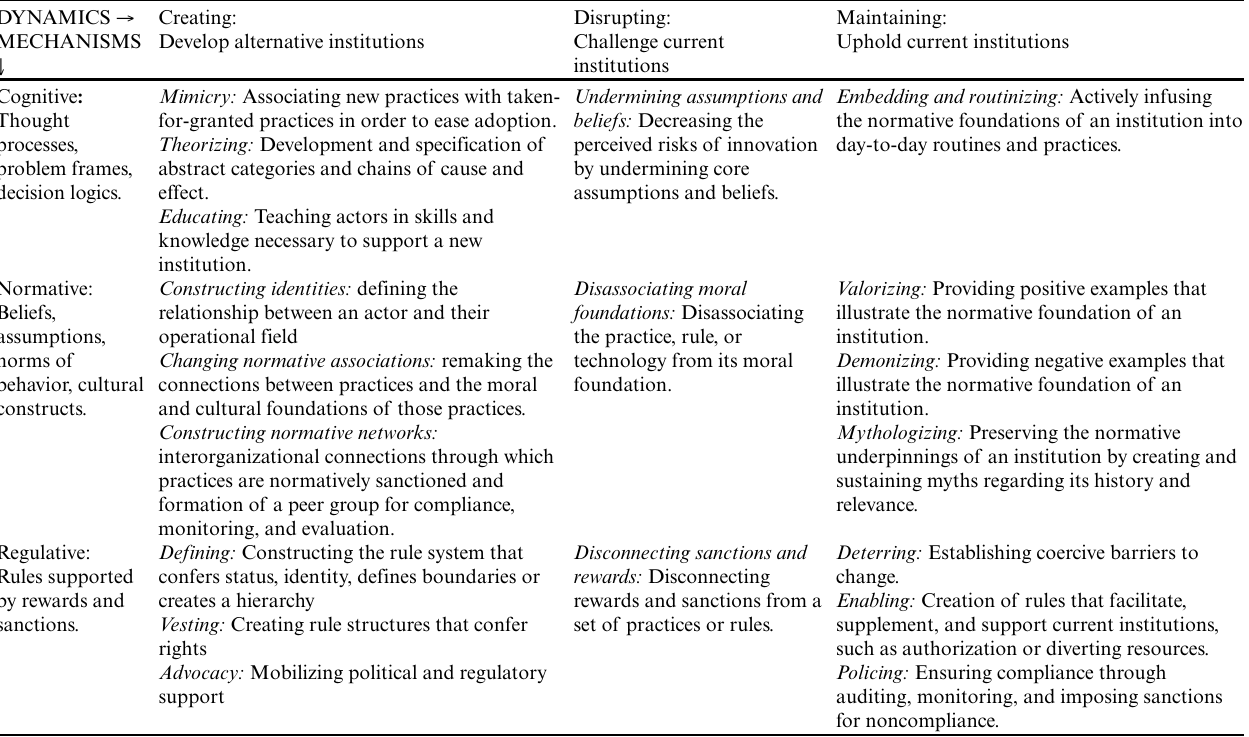
Table 1. Dynamics and mechanisms of institutional work DYNAMICS →